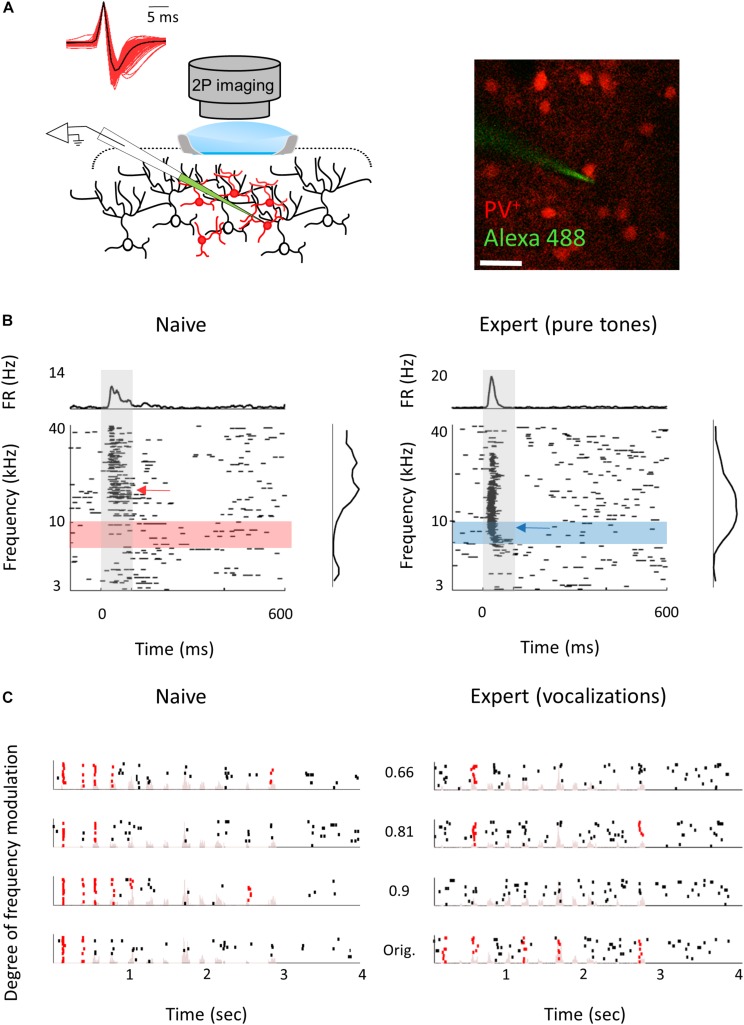
Response properties of PV+ neurons. (A) Left: Schematic representation of the experimental setup for two-photon targeted patch and average spike waveform of 203 PV+ neurons. Right: Representative two-photon micrograph (projection image of 120 microns) of tdTomato+ cells (red) and the recording electrode (Alexa Fluor-488, green). (B) Raster plots and peri-stimulus time histograms (PSTH) in response to pure tones of a representative PV+ neuron from naïve (left) and expert (right) mice. Gray bars indicate the time of stimulus presentation (100 ms). Color bars and arrows indicate the training frequency band (7.1–10 kHz) and BF, respectively. (C) Representative examples of raster plots from PV+ neurons in response to four modulated wriggling calls from naïve (left) and expert (right) mice. Red lines indicate spikes in response windows that are significantly above baseline. Stimulus power spectrum shown in light pink in the background.